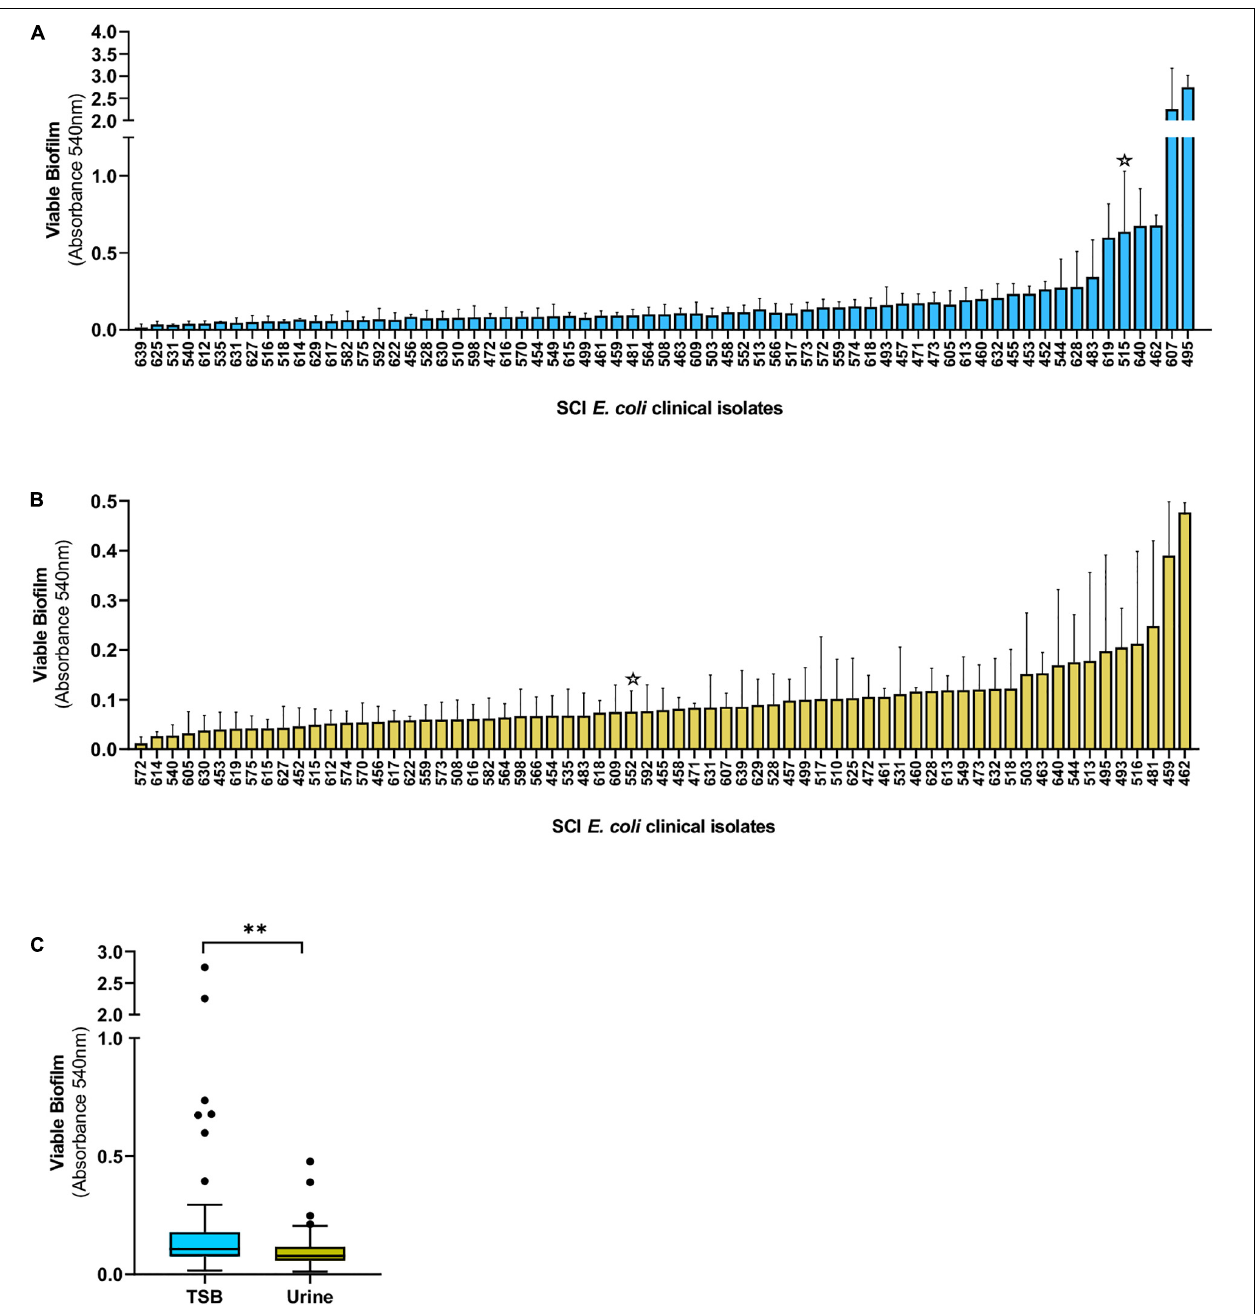
FIGURE 1 | Biofilm formation by E. coli isolated from the urine of patients with SCI. Biofilms were grown in TSB (A) or human urine (B) for 24 h and the levels of viable biofilm determined with an MTT assay. (C) Tukey’s style box and whiskers plot summarizing viable biofilm levels of all E. coli strains depicted in (A,B) . The stars indicate isolates DS515 and DS552 used for phage screenings in Figure 2 . ∗∗ p < 0.01 determined by Mann–Whitney